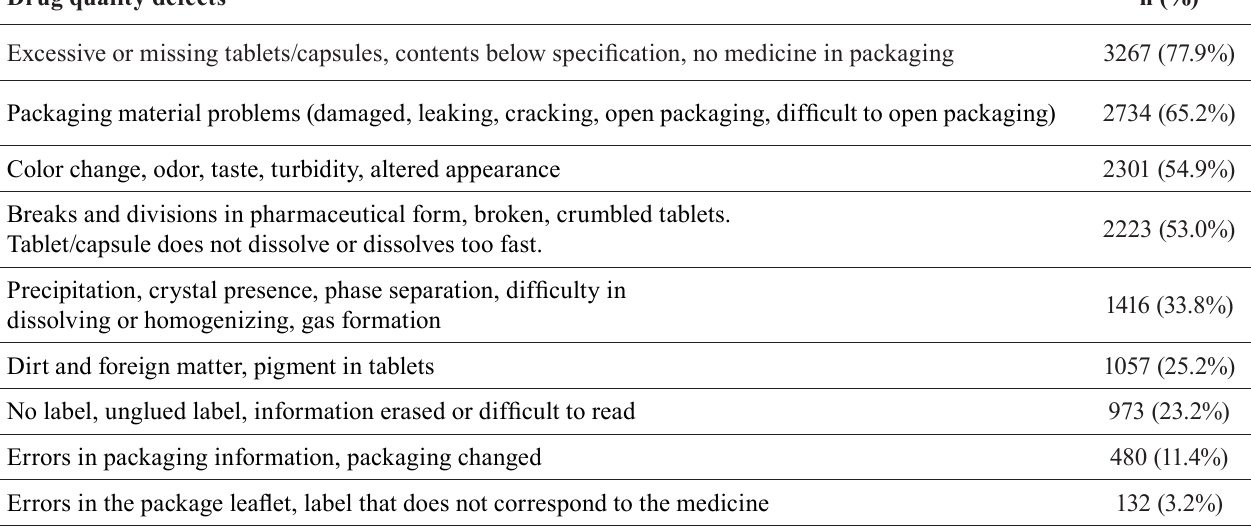
TABLE II – Drug quality defects identified by pharmacists (n=4195) Drug quality